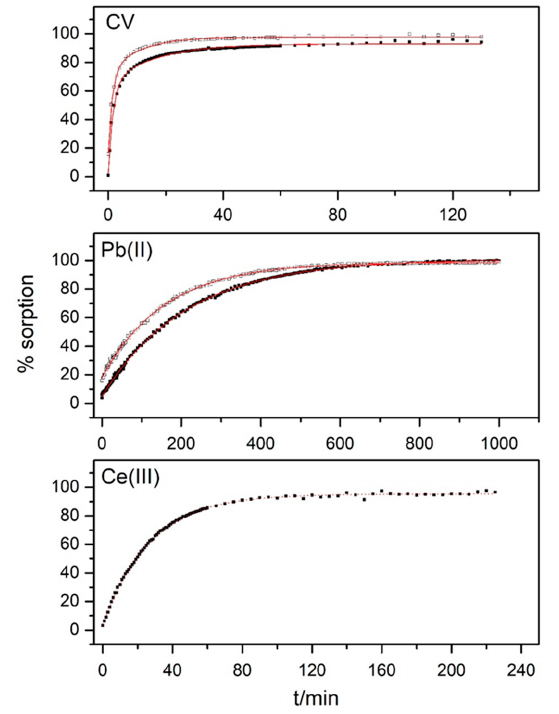
Figure 6. Kinetic profiles for the adsorption of CV, Pb(II) and Ce(III) onto K10-Mt at pH 6.0 ( ■ ) and pH = 2.0 ( □ ). pH = 2.0 ( (cid:3)